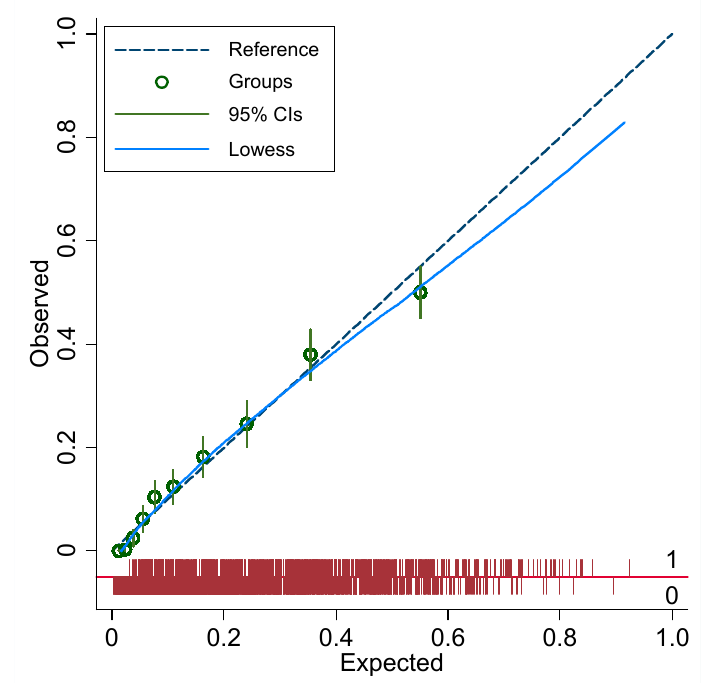
Figure 6. Calibration plot for the multivariable logistic regression model in people with secondary discharge diagnosis of diabetes. Each decile is denoted by a circle with a short intersecting line to indicate the corresponding 95% confidence interval. The diagonal smooth line (Lowess) indicates fair agreement between the observed and expected values.